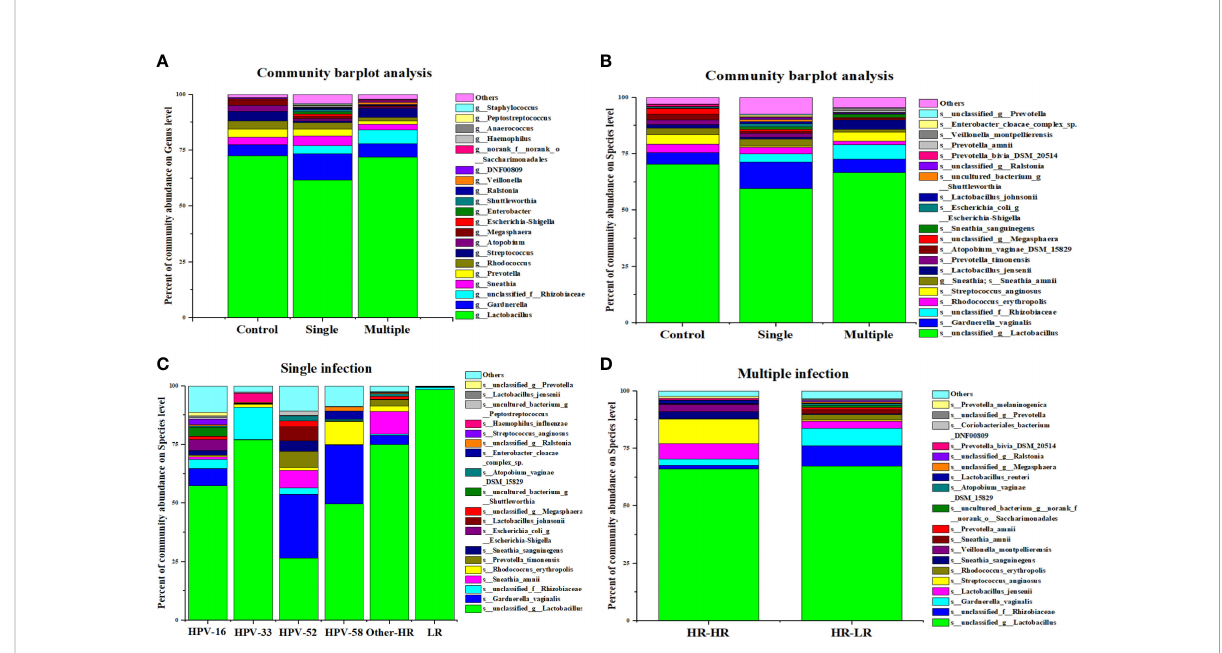
FIGURE 4 The composition of vaginal microbiota dependent on the HPV infection status. (A) Community barplot analysis on genus level among control, single infection and multiple infections. (B) Community barplot analysis on species level among control, single infection and multiple infections. (C) Community barplot analysis on species level related to HPV genotype in single infection group. (D) Community barplot analysis on species level related to genotype combination in multiple infection